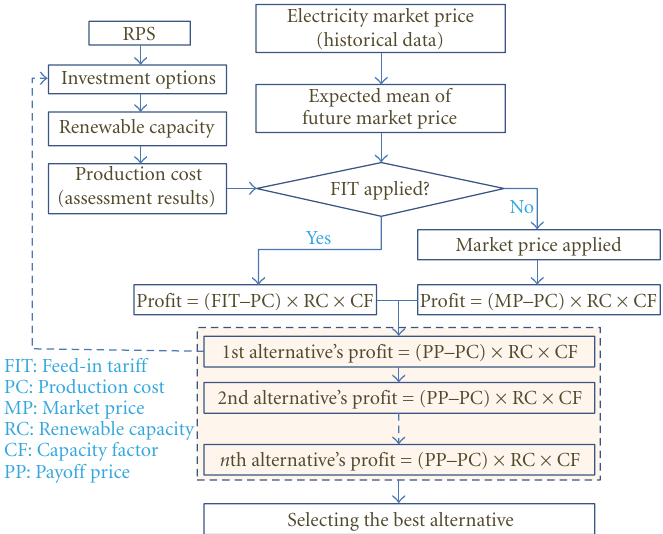
Figure 14: Decision-making algorithm for renewable capacity.